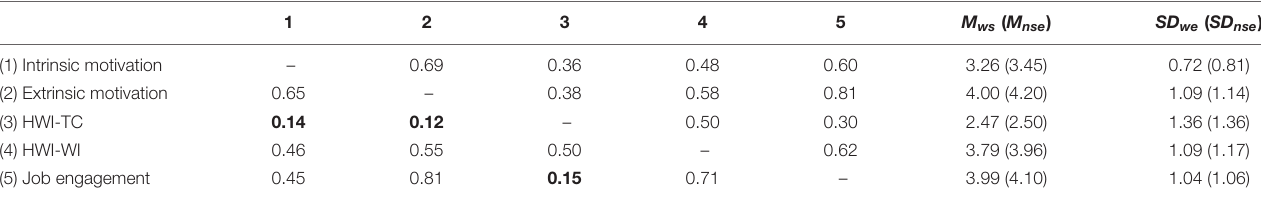
TABLE 3 | Pearson correlation matrix for working students ( below the diagonal; n = 97) and non-student employees ( above the diagonal; n = 74), means and standard deviations in the Japanese sample ( N = 171). 1 SD we ( SD nse )